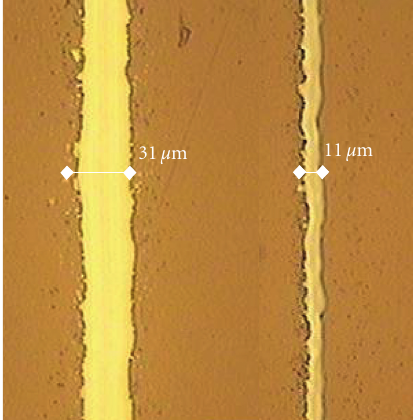
Figure 4: Comparison of A-DW printed lines made with Aerosol Jet (left) and CAB-DW (right) under identical print parameters (25sccm carrier gas, 15sccm sheath gas, 2mm stand-o ff height, 30mm/s translation), from Schulz et al. [18], Copyright 2010 IEEE.